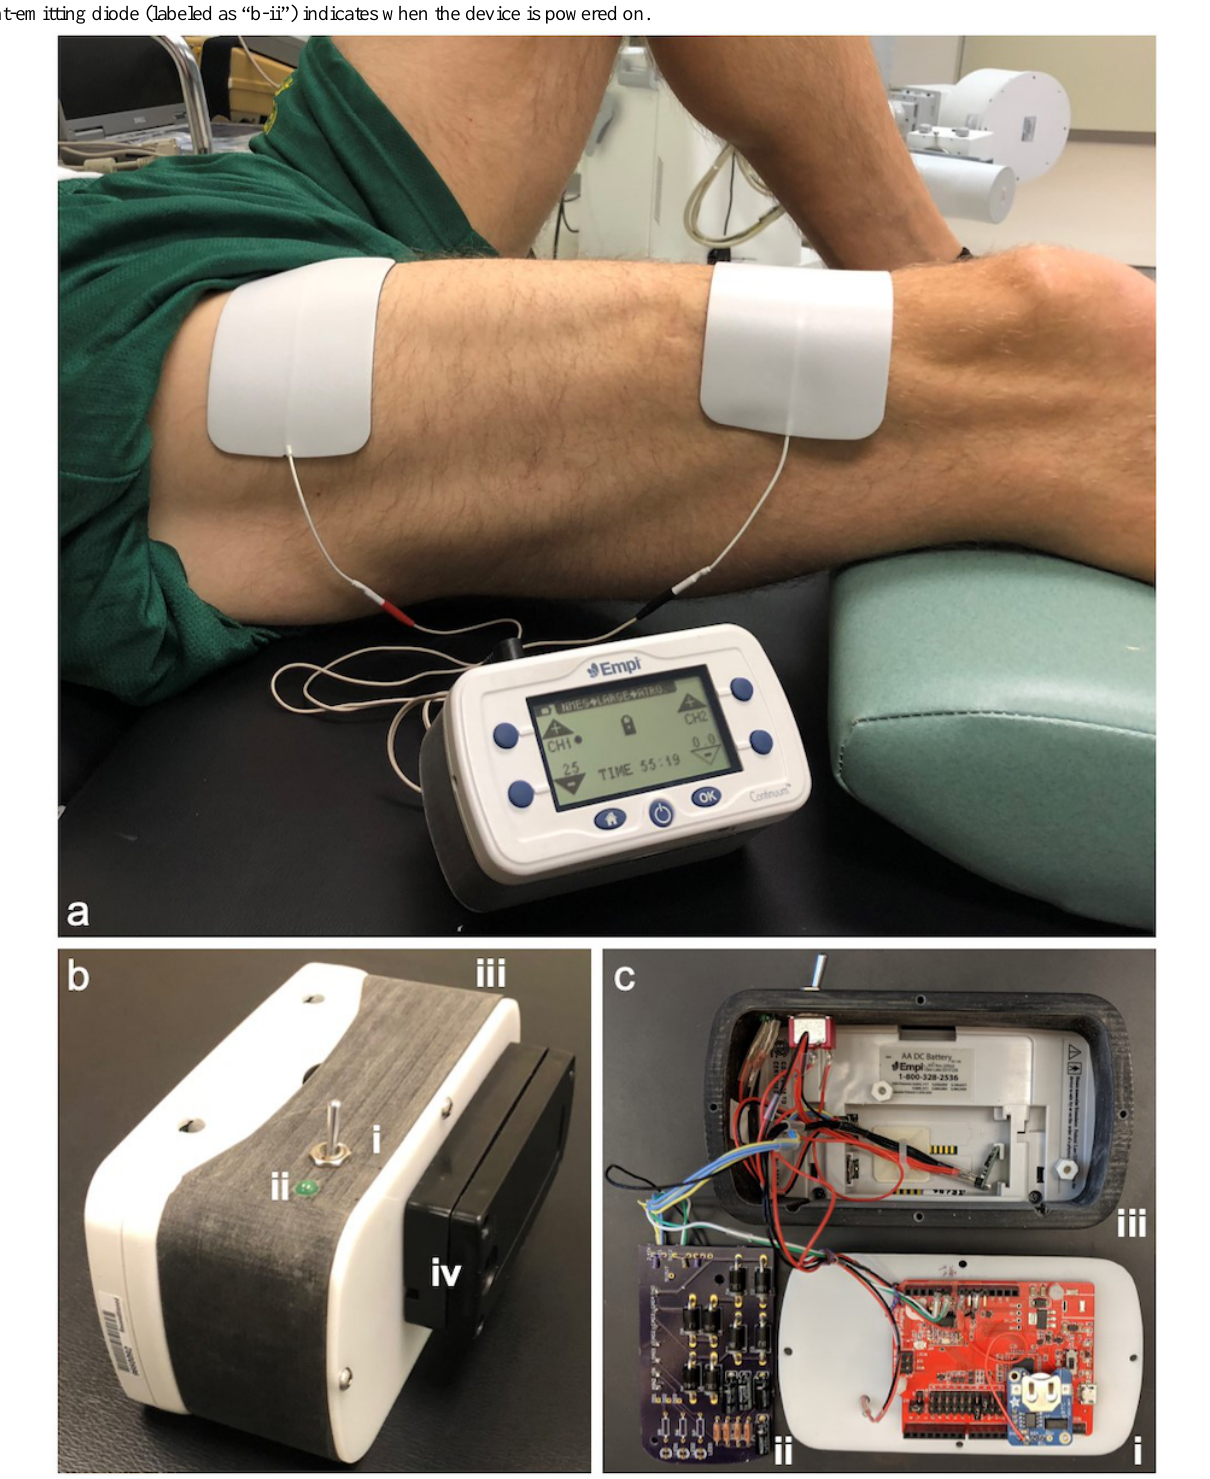
Figure 2. Modified neuromuscular electrical stimulation system can track the duration, intensity, and timing of rehabilitation sessions (labeled as “a”). Exploded view of the system, comprising a RedBearLab’s Blend BLE (labeled as “c-i”) and custom circuitry for quantifying device usage (labeled as “c-ii”) and integrated within a 3D-printed enclosure secured to the back of the EMPI (labeled as “b-iii”). Power is provided by two AA batteries secured in an external housing (labeled as “b-iv”) and is controlled by a master switch (labeled as “b-i”) and step-up regulator (labeled as “c-iii”). An external light-emitting diode (labeled as “b-ii”) indicates when the device is powered